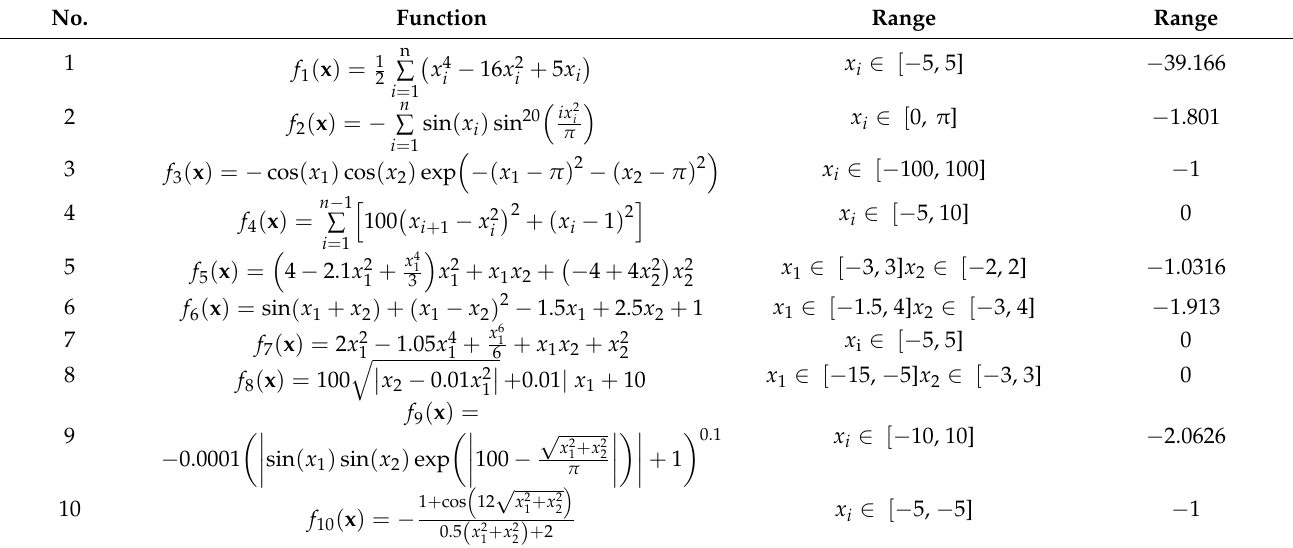
Table 1. Testing the Improved Genetic Algorithm with Multimodal